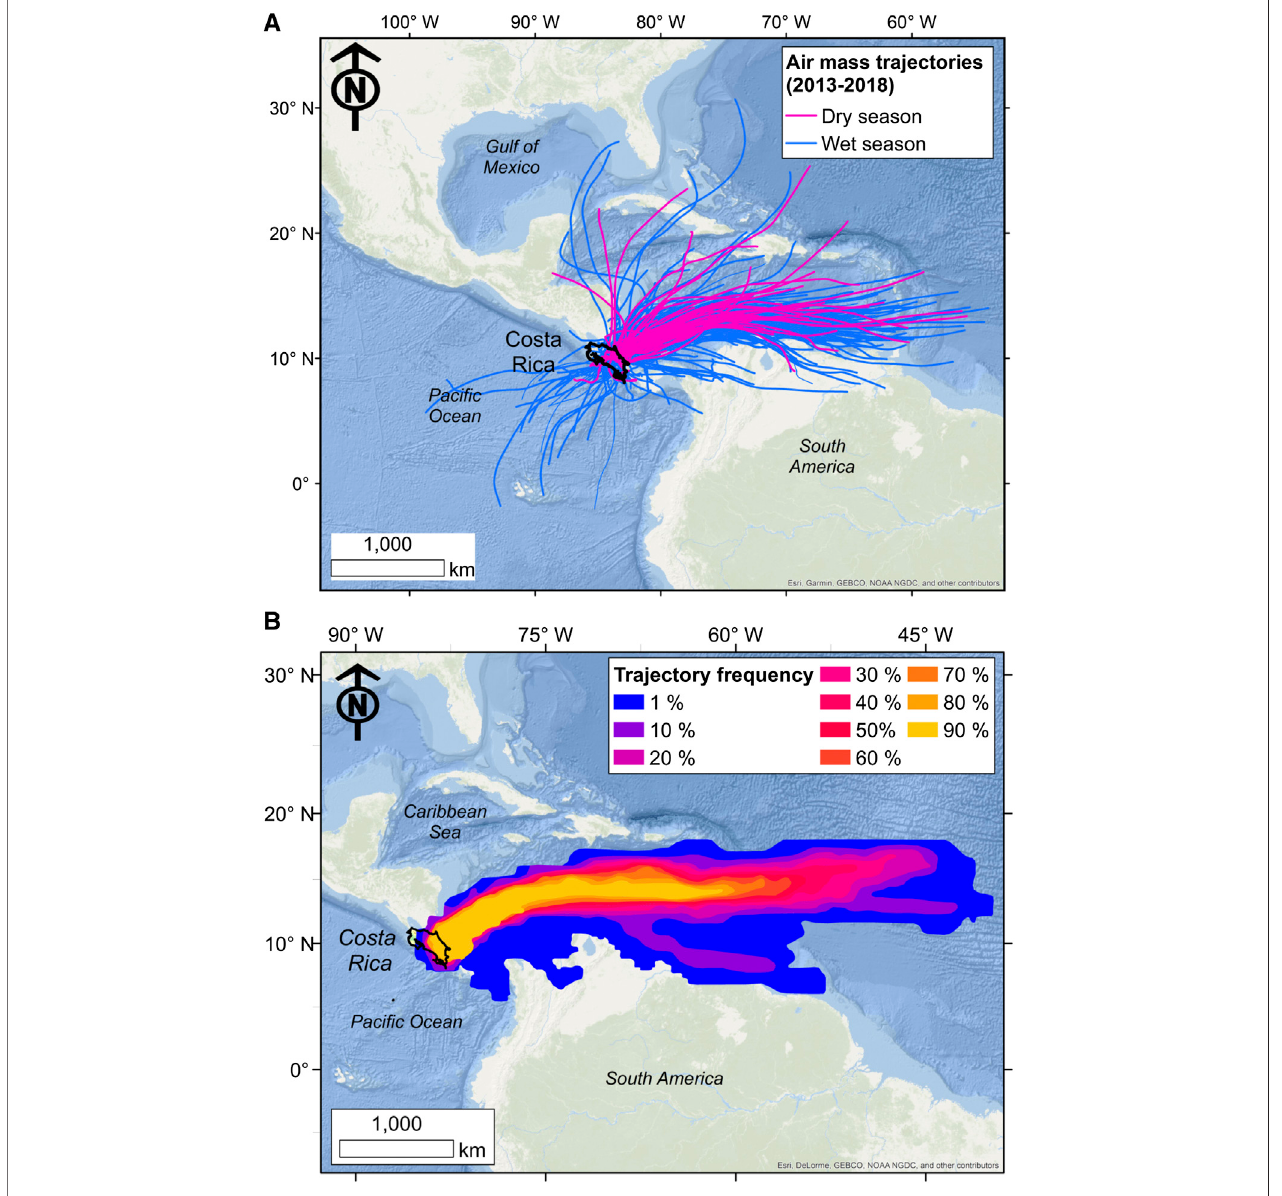
FIGURE 3 | HYSPLIT air mass back trajectories. (A) Air mass back trajectories (48 h backwards) for daily rainfall in central Costa Rica (2013 – 2018; N (cid:2) 593). Pink lines denote rainfall events in the dry season, whereas blue lines represent the wet season. (B) Color-coded trajectory frequency analysis (Esquivel-Hernández et al., 2019). Figure adapted using data from Sánchez-Murillo et al. (2016, 2017b, 2020) and Esquivel-Hernández et al.